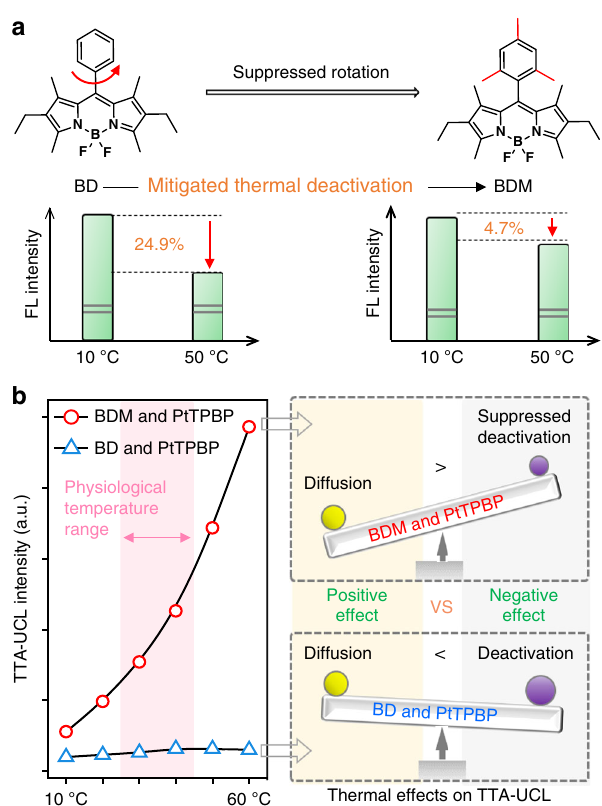
Fig. 2 Strategy for achieving highly positive thermal response in a TTA system. a The structure modi fi cation and thus suppressed thermal deactivations of fl uorescence. b The temperature responses of TTA-UCL signals emitted from BDM & PtTPBP and BD & PtTPBP, respectively. When negative deactivation effect is suppressed, the positive diffusion effect becomes more powerful to give a positive temperature-response trend with high sensitivity. A 635 nm laser (100 mW cm − 2 ) was used as the excitation source. The concentrations of BDM, BD, PtTPBP, and L -ascorbyl